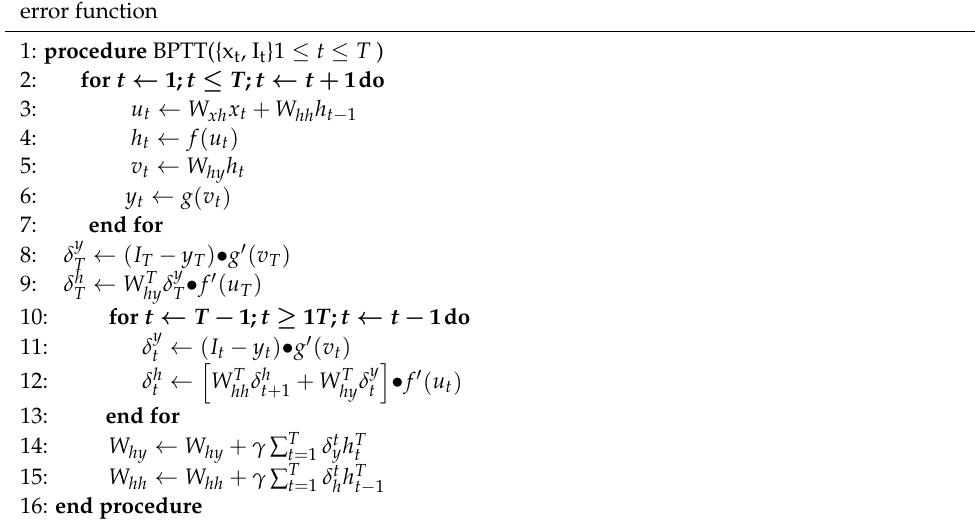
Algorithm 1. The time back propagation algorithm of a single-layer RNN with a square